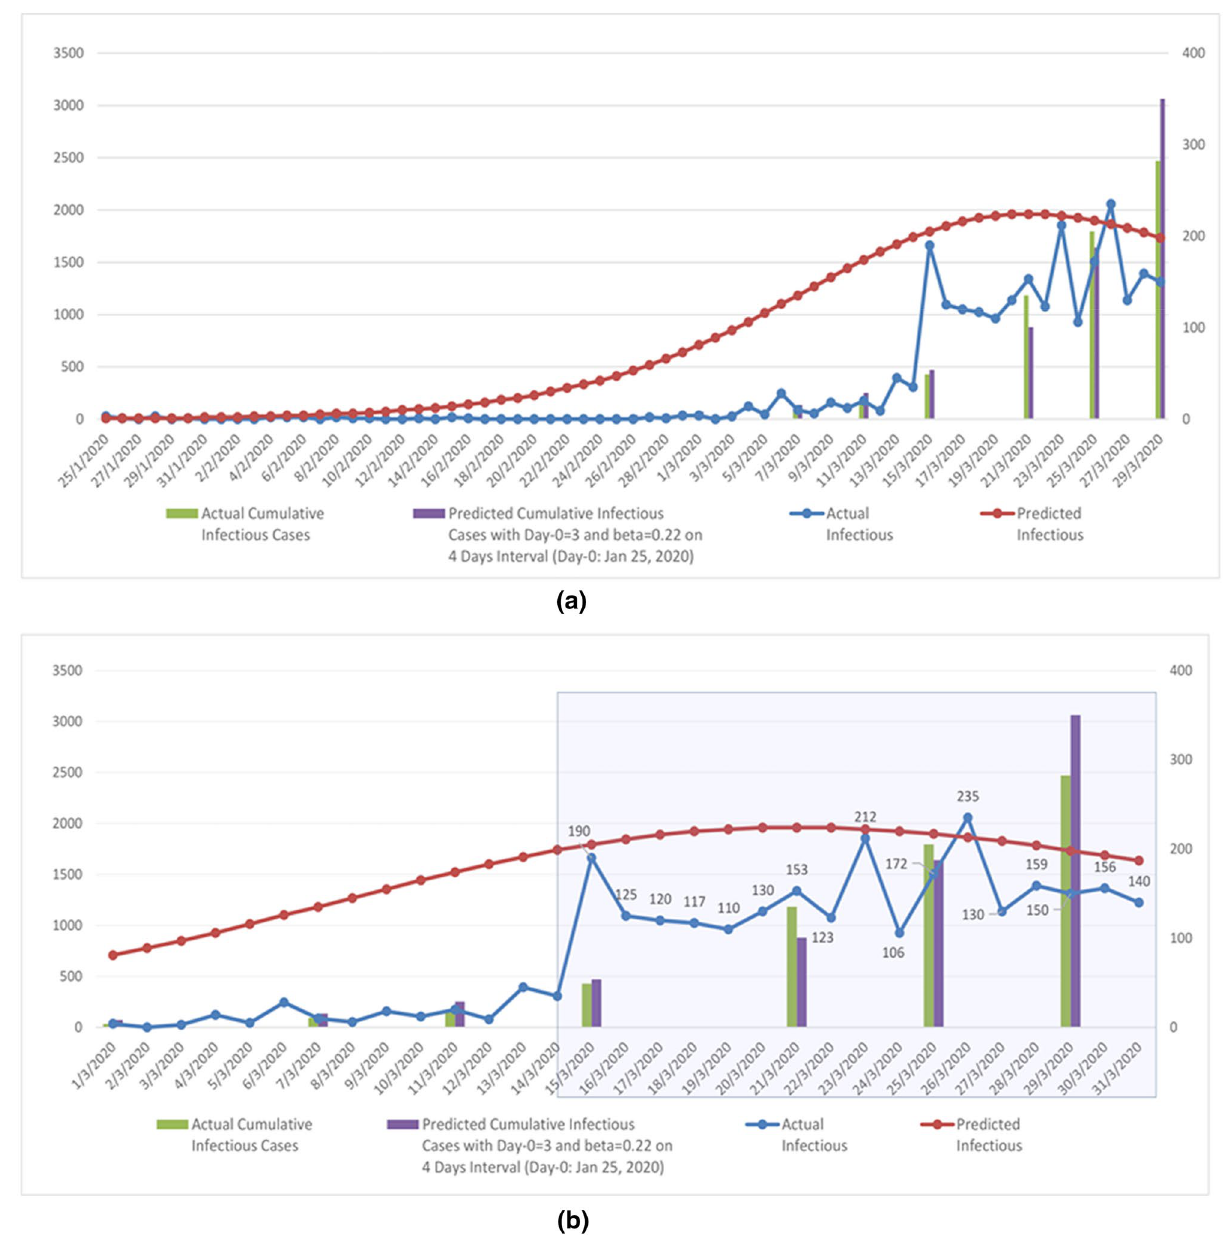
Figure 4. Actual versus Predicted Cases by date; ( a ) Jan 25 to Mar 31, 2020. ( b ) Mar 1 to Mar 31,